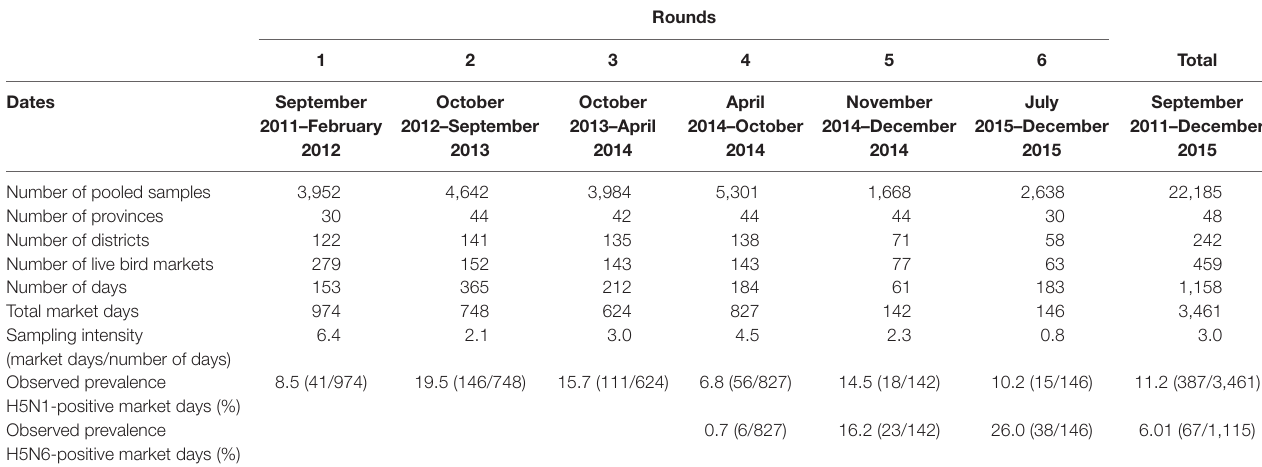
TaBle 3 | Sampling characteristics and prevalence of highly pathogenic avian influenza H5N1- and H5N6-positive market days of the six surveillance Rounds.